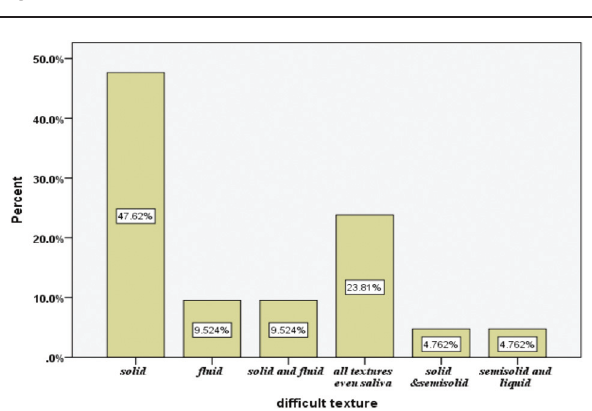
Receiver operating characteristic curve (ROC) for the GUSS as a predictor of aspiration risk.